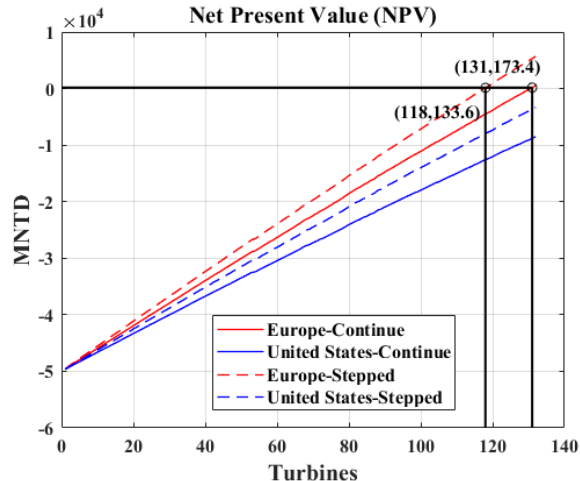
Figure 10. Net present value for different numbers of turbines considering the purchase price of wind energy in Taiwan.